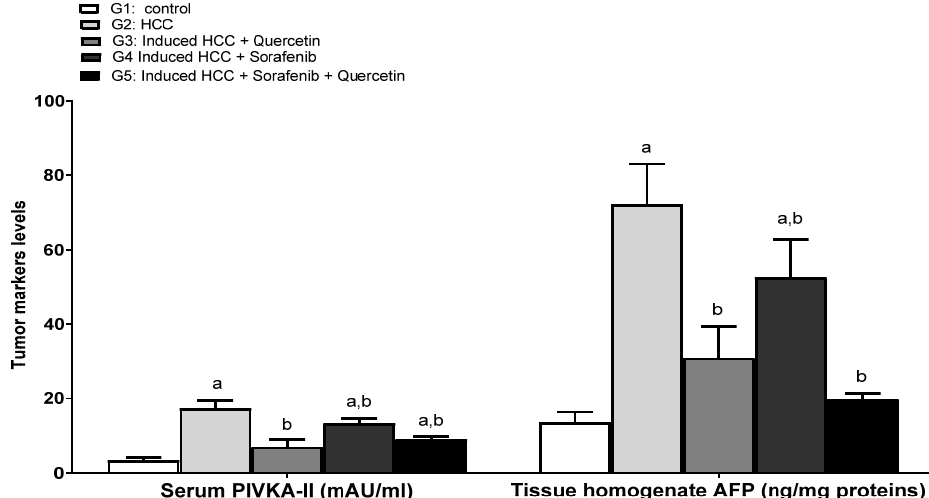
Figure 6. Tumor marker PIVKA-II and tissue homogenate of AFP in different studied groups. Data were expressed as mean +/ − standard deviation. Significance was made using one-way ANOVA test followed by least significant test. a: significance versus group 1. b: significance versus group 2.